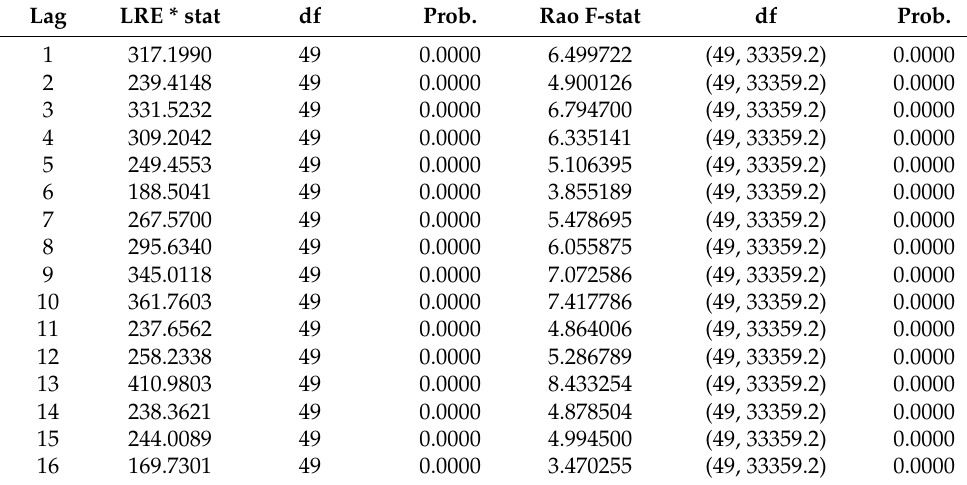
Note: * Likelihood ratio statistic with Edgeworth expansion correction. Null hypothesis: No serial cor- relation at lag h. Sample: 1/05/2015 4/01/2020. Included observations: 6702. Source: Own Elaboration.